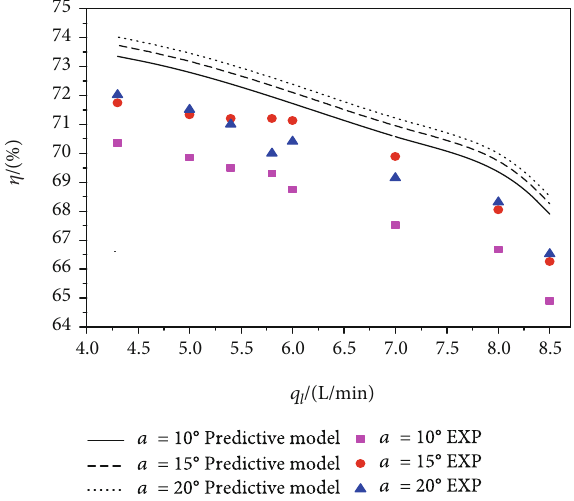
Figure 5: Comparison of separation e ffi ciency at di ff erent inlet inclination